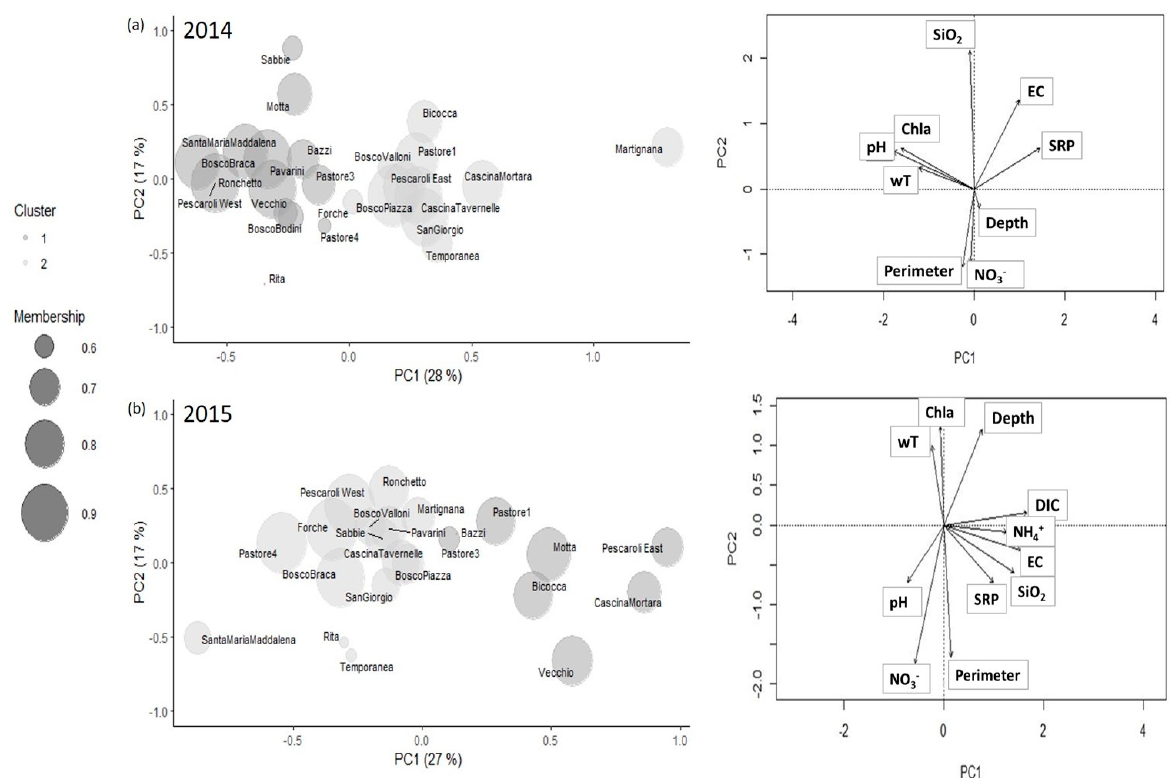
Figure 2. Principal component analysis (PCA) for the 2014 ( a ) and 2015 data ( b ). In 2014, nine environmental features were considered, and the first two principal components explained 45% of the variance. In 2015, 11 environmental features were considered and the first two principal components explained 44% of the variance. Each pond was represented by a bubble with size proportional to the membership value of the pond to a cluster. In both years, the fuzzy c-means algorithm identified two clusters: Cluster 1 (dark grey) and Cluster 2 (light grey). On the right side, the loadings of each variable were reported. The arrow lengths provided the degree of correlation among each original variable and the principal components.